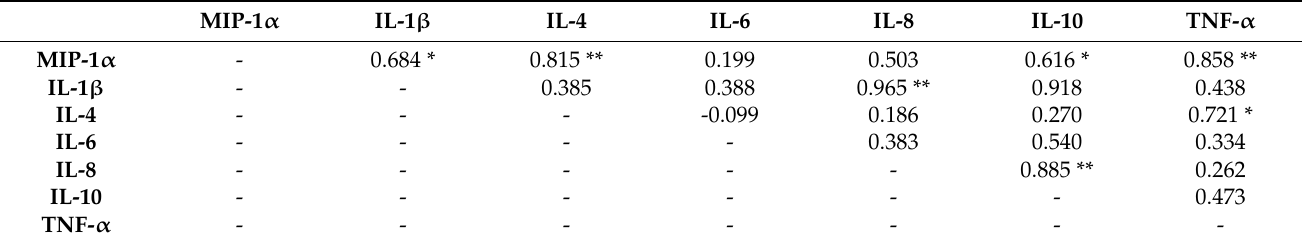
Table 5. The correlation coefficient r between serum values of cytokines at the